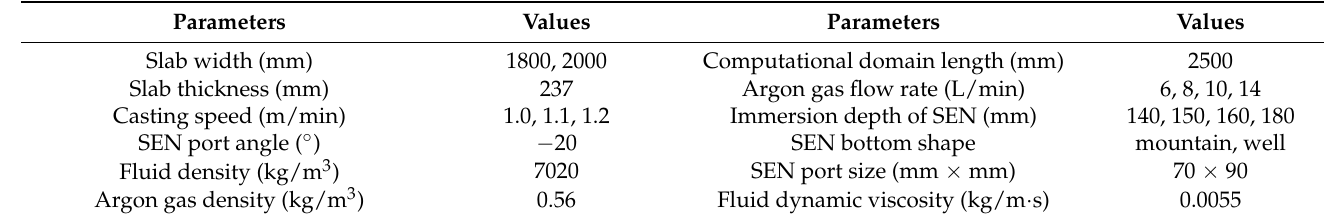
Figure 2. Geometry and computational meshes of the mold. Table 1. Parameters of experiment and numerical